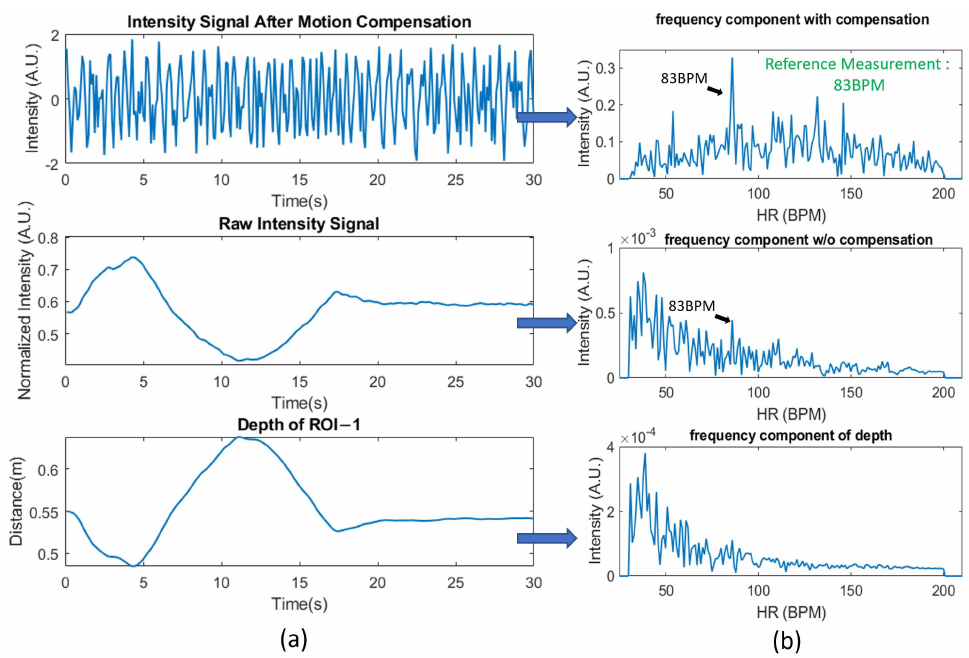
Figure 8. ( a ) Time domain signal for HR extraction: HR signal after motion compensation (top), raw grayscale signal (middle) and raw depth signal (bottom). ( b ) Frequency domain HR signal: with motion-compensation (top), without motion compensation